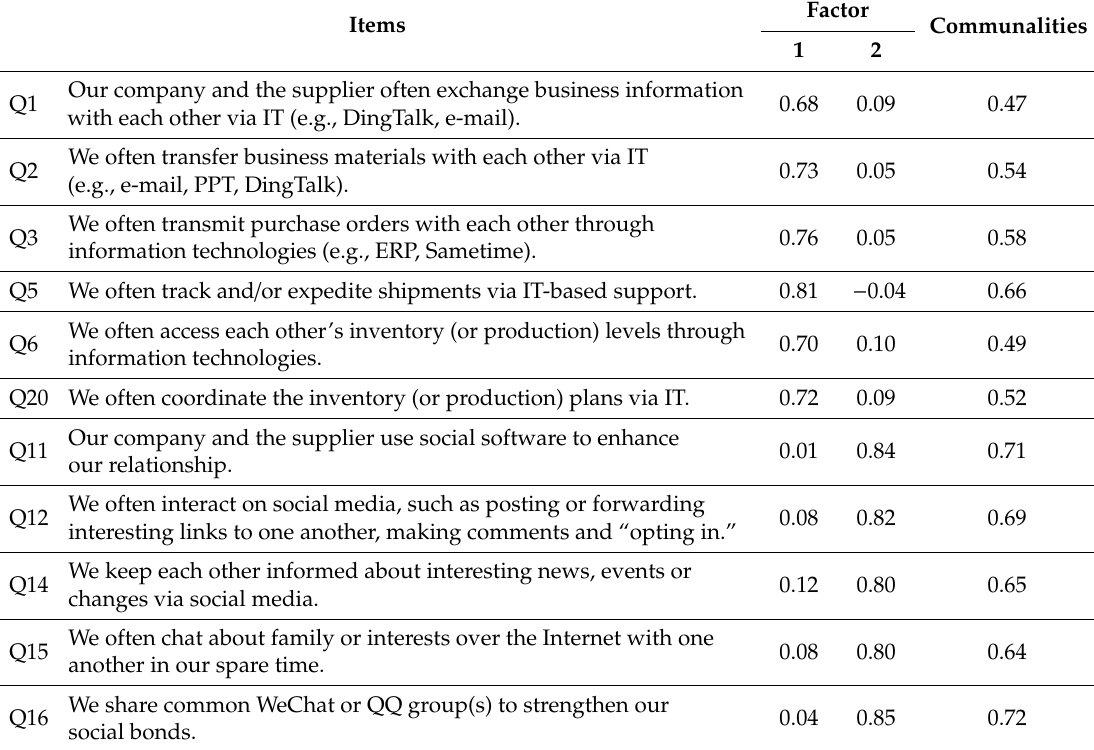
Table 4. The exploratory factor analysis (EFA)